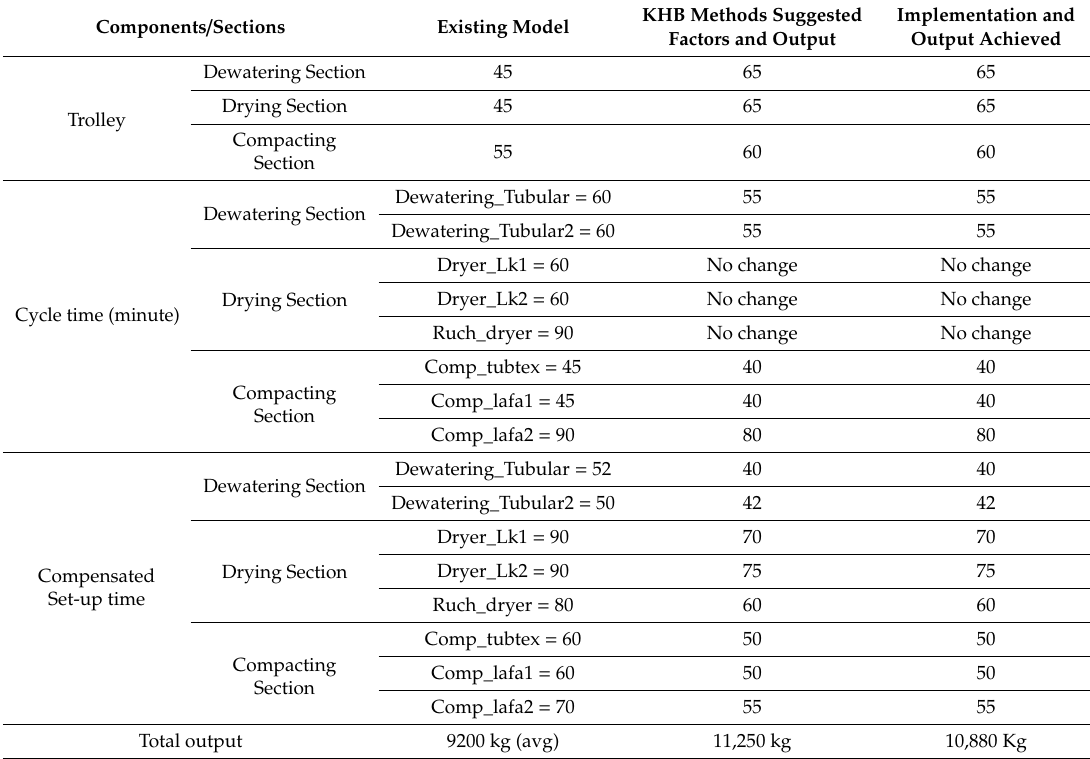
Table 4. Modification list of the tubular production line.